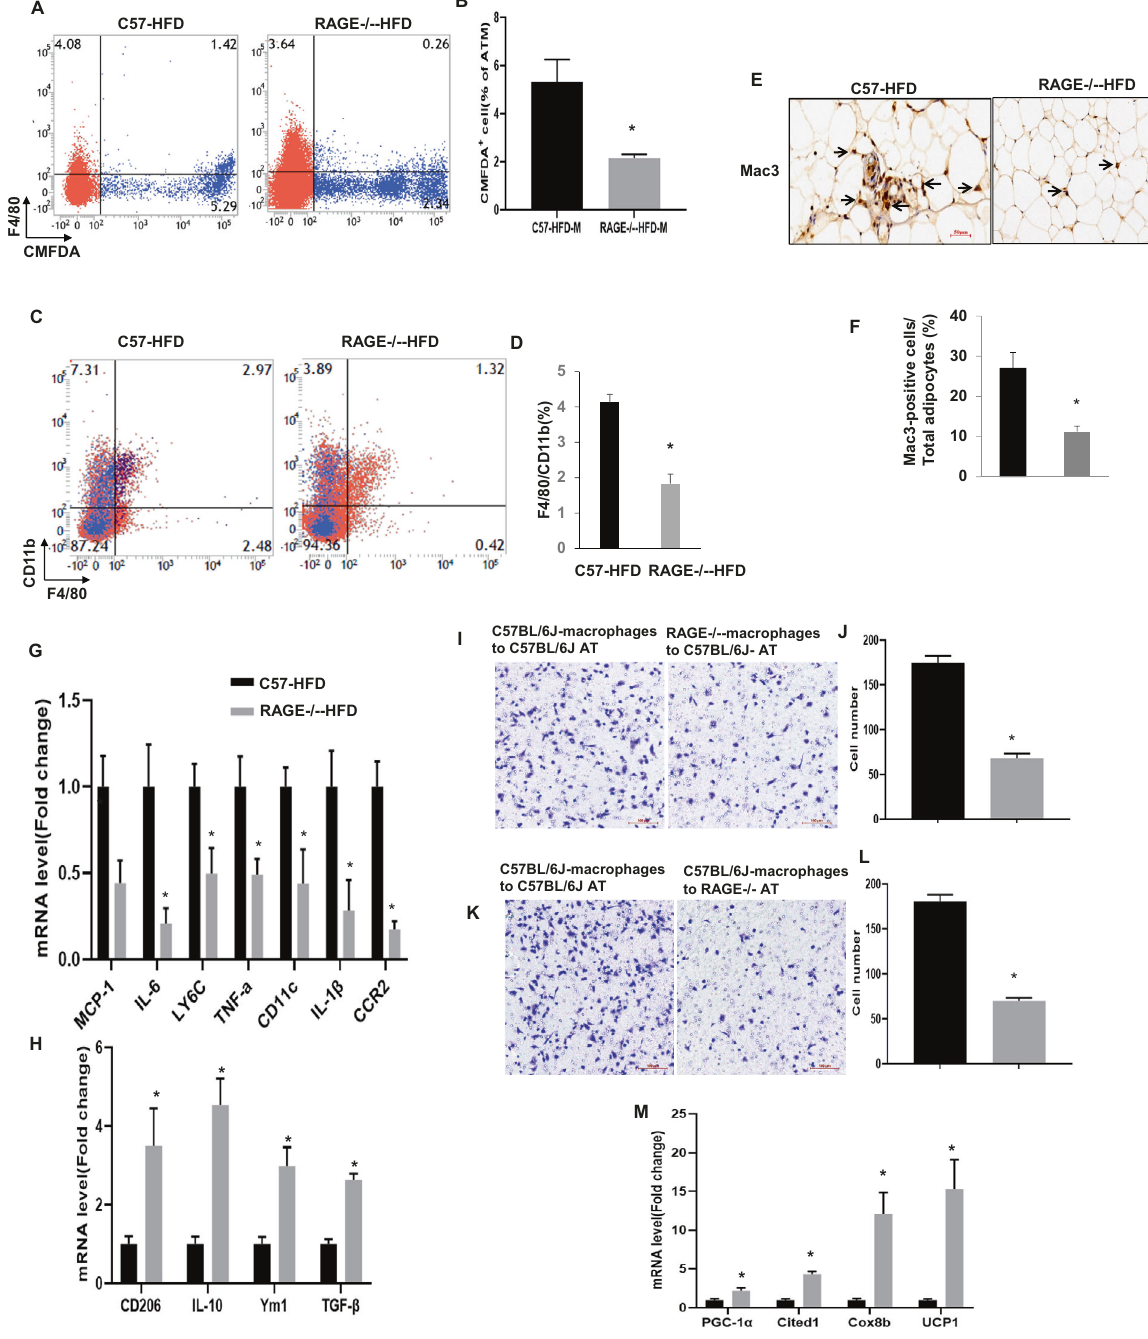
Fig. 2 RAGE de fi ciency decreases the accumulation of adipose tissue macrophages. Quantitation by fl ow cytometry of the proportion of CMFDA + ATMs ( A , B ) and CD11b + F4/80 + ( C , D ) in the SVF of eAT from WT-HFD and RAGE − / − -HFD mice. n = 6 per group; *P < 0.05 Vs. WT-HFD mice. E , F Immunohistochemical detection of Mac3 in eAT of from HFD mice. n = 6 per group; * p < 0.05 Vs. WT-HFD mice. Magni fi cation, ×200, is indicated as the ratio of Mac3-positive cells to total cells. Scale bars: 50 μ m. G , H Quantitative RT-PCR analysis of total RNA isolated from eAT for IL-6, IL-1 β , TNF- α , MCP-1, and CD11c, IL-10, YM1, TNF- β , and CD206 mRNAs. Data were normalized by the amount of 18s mRNA and expressed relative to the corresponding WT-HFD. n = 6 per group. *P < 0.05 Vs. WT-HFD mice. I , J Isolated peritoneal macrophages as indicated were added to upper chambers. eAT from either WT-HFD or RAGE − / − -HFD mice were chopped into approximately 1 mm pieces, and then 50 mg of chopped eAT were placed in the lower chambers. After 6 h of incubation, cells were fi xed and stained with crystal violet. Migrated cells were counted. Representative images of cell migration are shown. K , L Quantitative assessment of triplicate migration experiments was performed. *P < 0.05 Vs. WT-HFD mic-derived eAT. M Ucp1 , Pgc1a , Cited1 , and Cox8b mRNA expression levels in the eAT of WT-HFD and RAGE − / − -HFD mice. n = 6 per group; *P < 0.05 Vs. WT-HFD mice. All group data are shown as mean ± SEM.